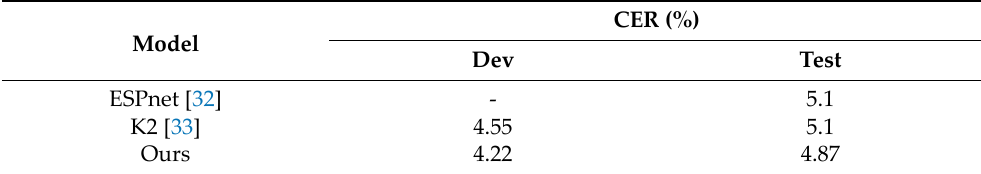
Table 2. The CER of the baseline